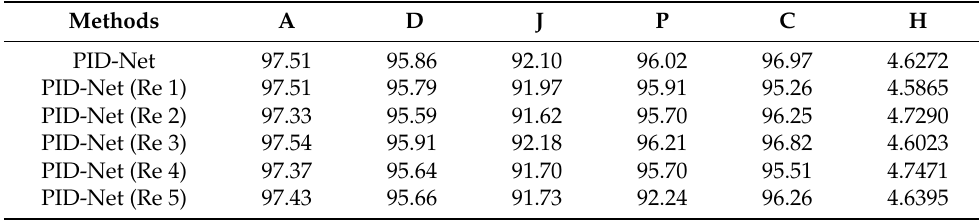
Table 5. The evaluation indices of Repeatability Tests. A, D, J, P, C and H are abbreviations of the Accuracy, Dice, Jaccard, Precision, Counting Accuracy (in %) and Hausdorff Distance (in pixels/per image),